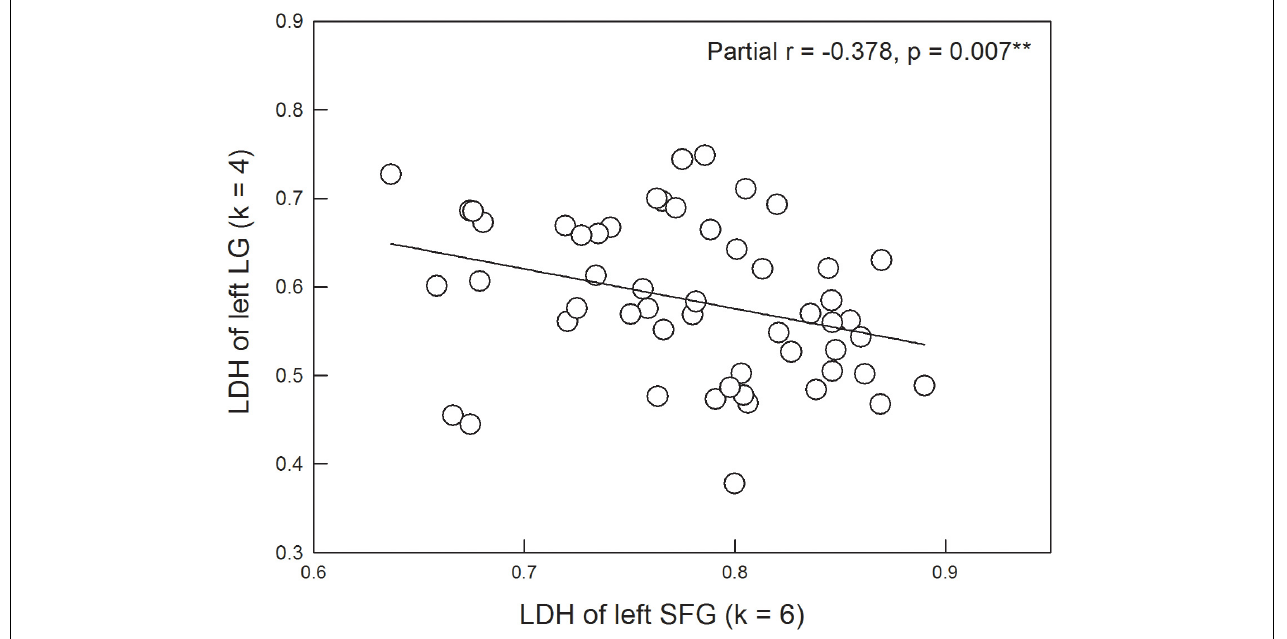
FIGURE 4 | LDH of the left superior frontal gyrus (SFG) is significantly correlated with LDH of the left lingual gyrus (LG) after controlling the age, gender, years of education, and scores of the Geriatric Depression